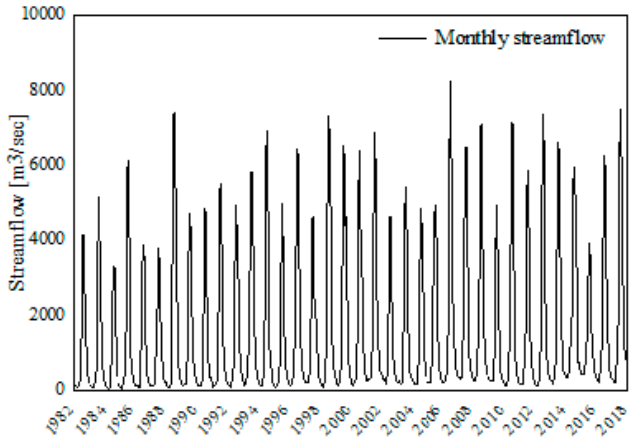
Figure A2. Soil moisture.